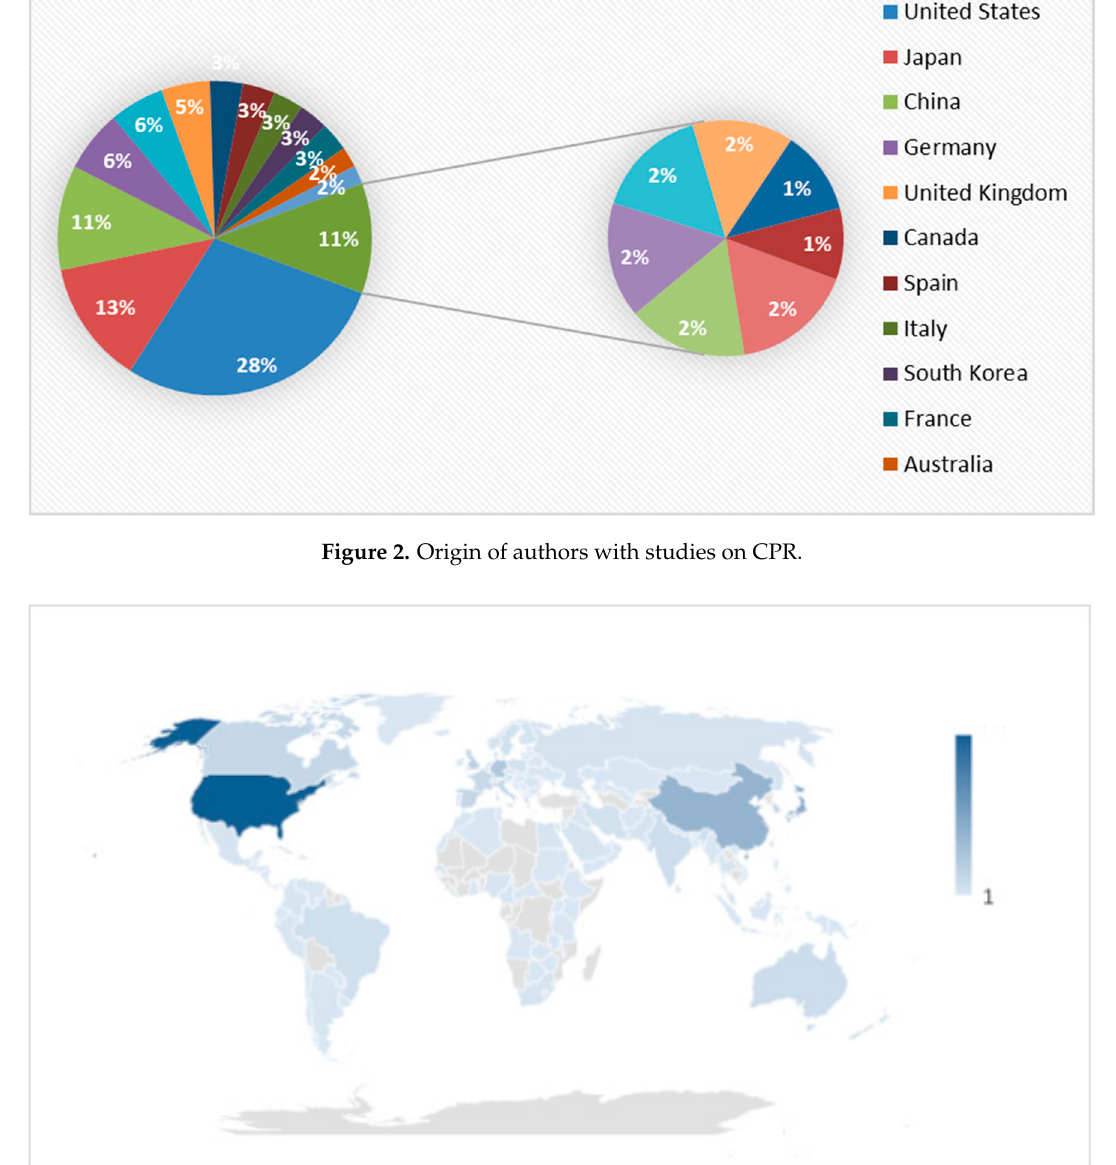
Figure 3. World map of CPR research.